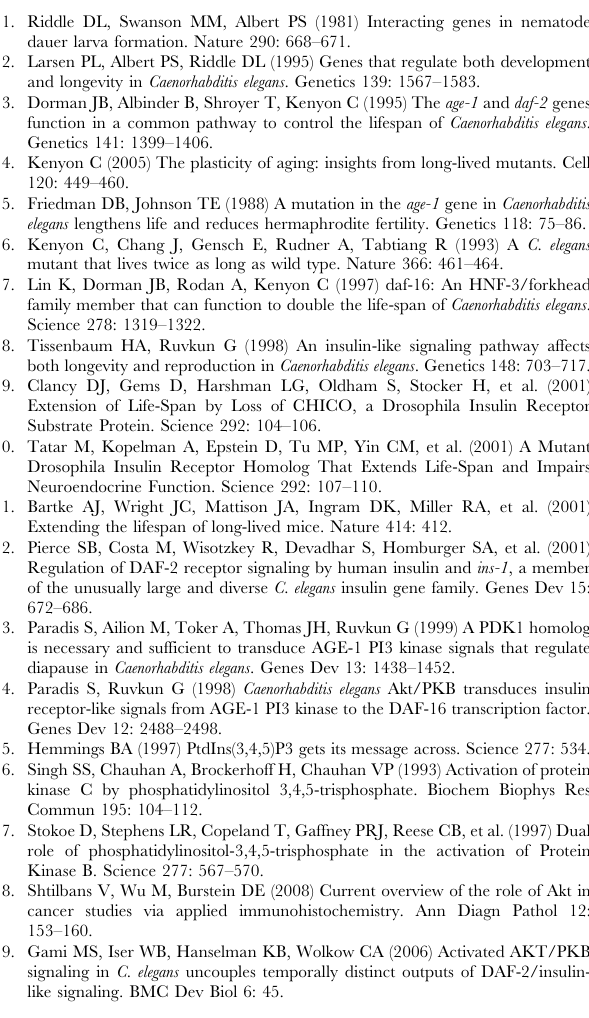
Table S2 Gene expression data, quantified by real-time polymerase chain reaction, comparing three age-1 mutant groups to daf-2(e1370) mutants. Worms in the age-1(mg44) F2 group are sterile adults; others are post-gravid adults. Significance of difference from N2DRM (t-test): u , nominally significant at P , 0.05; *, P , 0.01; **, P , 0.001; ***, P , 1E 2 4; ****, P , 1E 2 5, *****, P , 1E 2